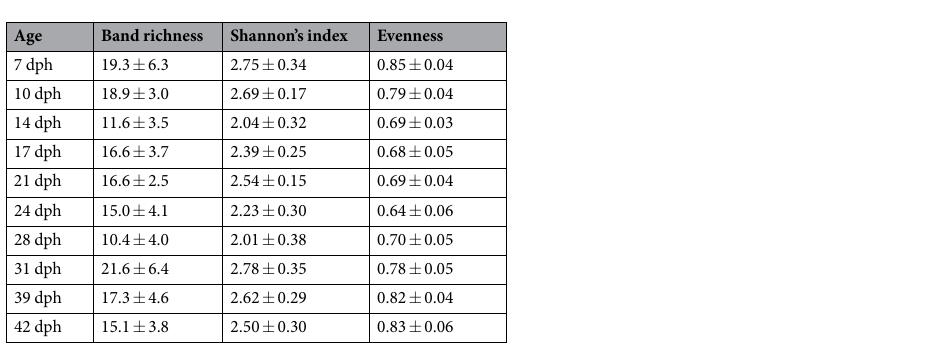
4 SCieNTifiC RepORTS | 7: 8611 | DOI:10.1038/s41598-017-09073-9